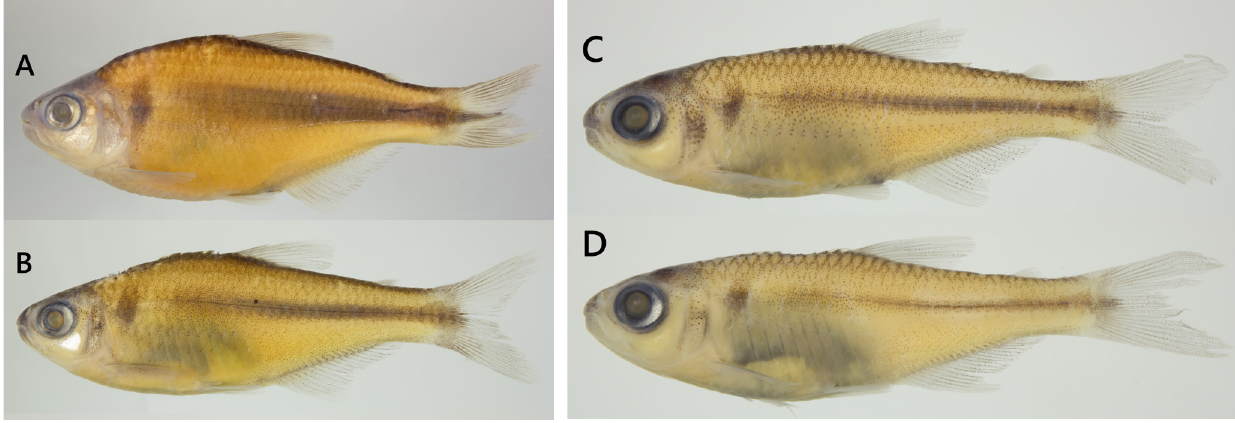
FIGURE 10 | Knodus aff. breviceps from the rio das Almas basin, upper Tocantins basin (collected in syntopy with K. obolus and K. rufford ). A . NUP 22666, 55.3 mm SL. B . NUP 22662, 42.0 mm SL. C . NUP 22665, 28.2 mm SL. D . NUP 22665, 23.9 mm